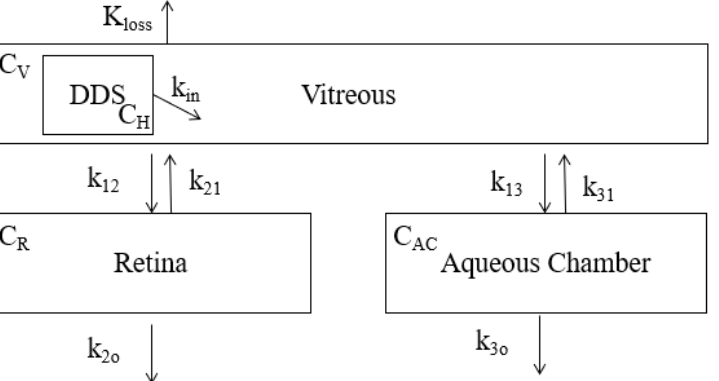
Figure 5. Compartment model that considers the layers of tissues that a drug must transverse in order to enter the vitreous chamber following an intravitreal entry point. The encapsulated drug flows out of the DDS directly into the vitreous. From there, drug exchange can occur between the vitreous and the retina and the vitreous and the aqueous chamber. Additional systemic drug loss ( K loss ) is also considered. C H , C V , C R and C Ac represent the drug concentration in their respective compartments. All values of k represent the rate of drug flow into and out of their respective compartments.